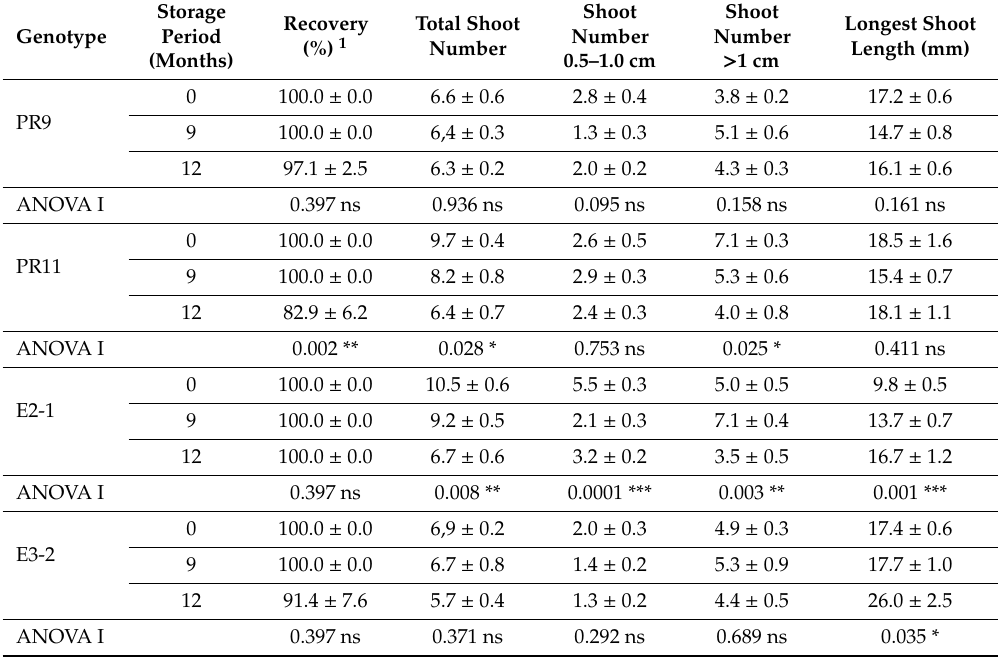
Table 6. E ff ect of cold storage period on recovery and proliferation capacity of shoot cultures derived from four tolerant Q. ilex